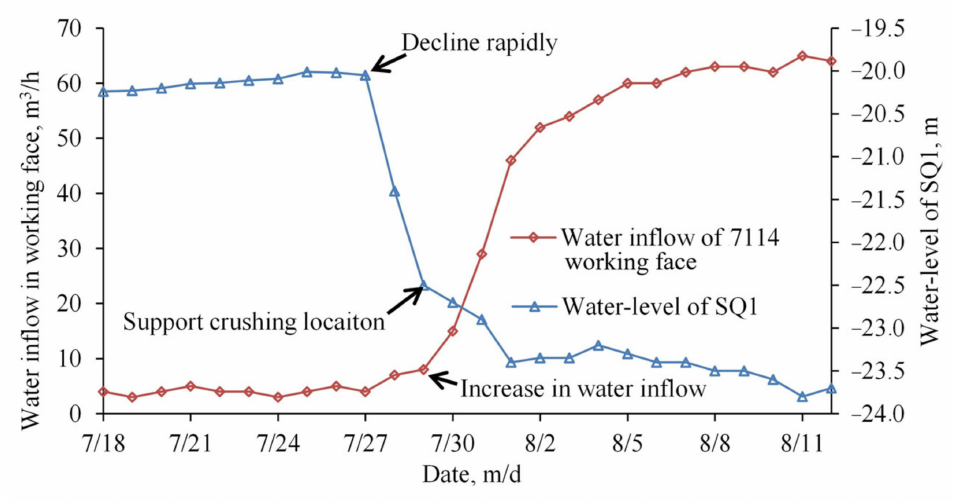
Figure 9. Relationship between water inflow and water-level variation in 7 1 14 working